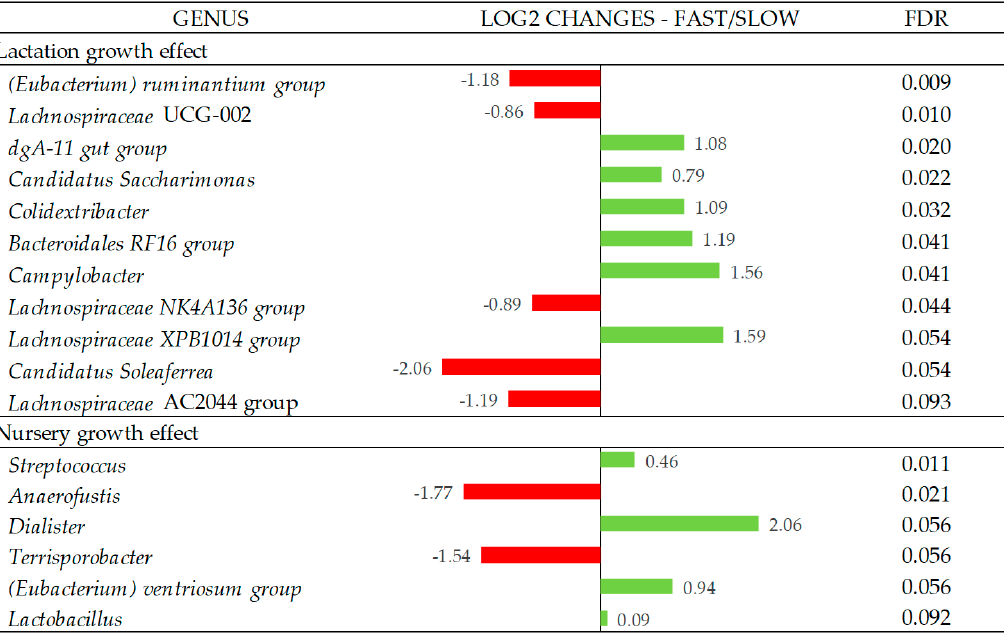
Figure 3. Log2 changes between the fast- and slow-growth pigs during the lactation and nursery periods (fold discovery rate p -adjusted < 0.1) in microbial genera. Taxa are sorted by the level of significance (from higher to lower). Differences presented are based on all taxa detected in the sam- ples per group. Sample size for the differential abundance analysis: Fast_Fast ( n = 19), Fast_Slow ( n = 18, missing samples = 1), Slow_Fast ( n = 17, missing samples = 2), and Slow_Slow ( n = 17, missing samples = 1).